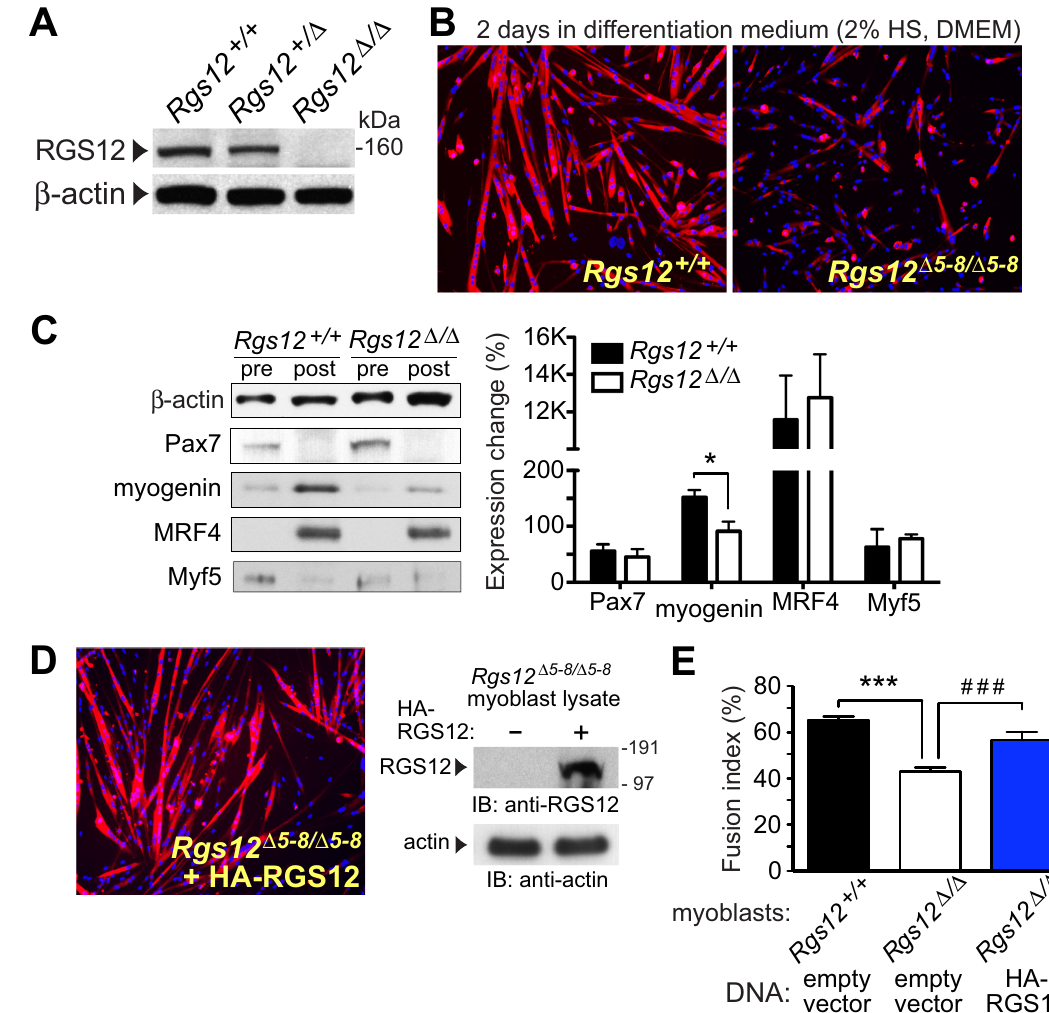
Fig 5. Myotube formation by primary myoblasts isolated from RGS12-null mice is disrupted, but restored upon RGS12 re- expression. (A) Confirmation of RGS12 loss in primary myoblasts from Rgs12 Δ 5-8/ Δ 5–8 mice via immunoblotting of myoblast lysates with indicated antibodies. Skeletal muscle myoblasts were isolated from tibialis anterior (TA) muscles of 2- to 3-week old homozygous Rgs12 Δ 5-8/ Δ 5–8 mice, heterozygous Rgs12 +/ Δ 5–8 mice, or wild-type littermate controls, and cultured in F10